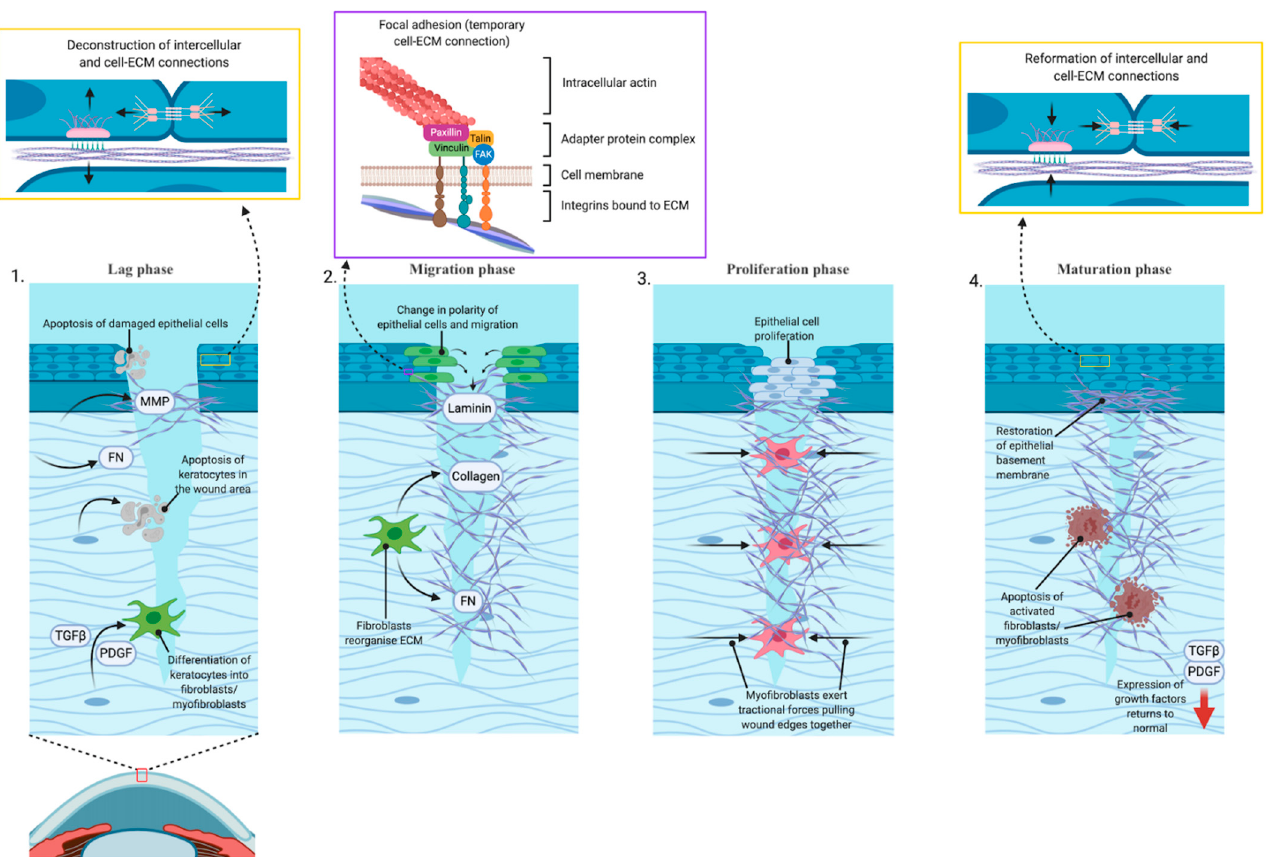
Figure 1. The corneal wound healing process summarized as four steps. (1) Lag phase immediately after injury: cellular remodeling and expression of matrix metalloproteinases (MMP) and fibronectin (FN). Deeper stromal keratocytes undergo fibroblastic change via transforming growth factor β (TGF β ) and platelet-derived growth factor (PDGF). (2) Migration phase. Deposition of extracellular matrix (ECM) materials and reorganization of the provisional matrix. Temporary connections form via cell–ECM focal adhesions. (3) Proliferation phase. Epithelial cell proliferation with continued ECM secretion and traction to close wound. (4) Maturation phase. Restoration of epithelial basement membrane, decreased cellular activity, and apoptosis.